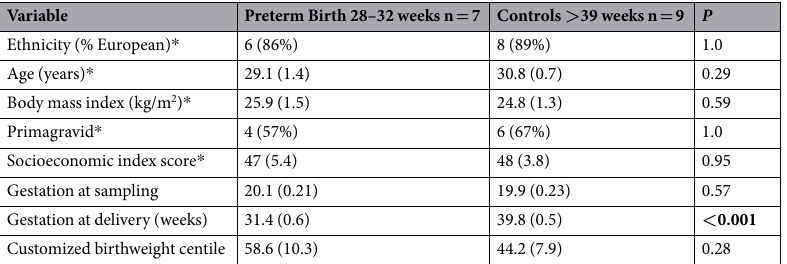
Table 1. Demographic and clinical findings. For analyses, only those with Nanostring results were included; Term controls; n = 9, SPTB n = 7. Data are number (%) or mean (SEM) as appropriate. * Data are collected at 14–16 weeks’ gestation. P values are for comparing between the two groups using Fisher’s Exact Test or Student t-test. Outside of the gestational age at time of delivery, there were no differences in baseline characteristics between the two maternal groups. There were also no differences between the total original cohort assessed (n = 12 per group) and those for which Nanostring data were subsequently available for